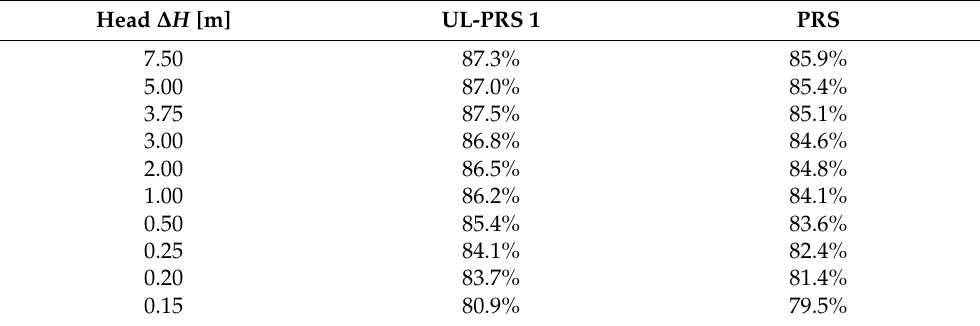
Table 3. Two-dimensional efficiency comparison between UL-PRS1 and PRS turbines for different head jumps.